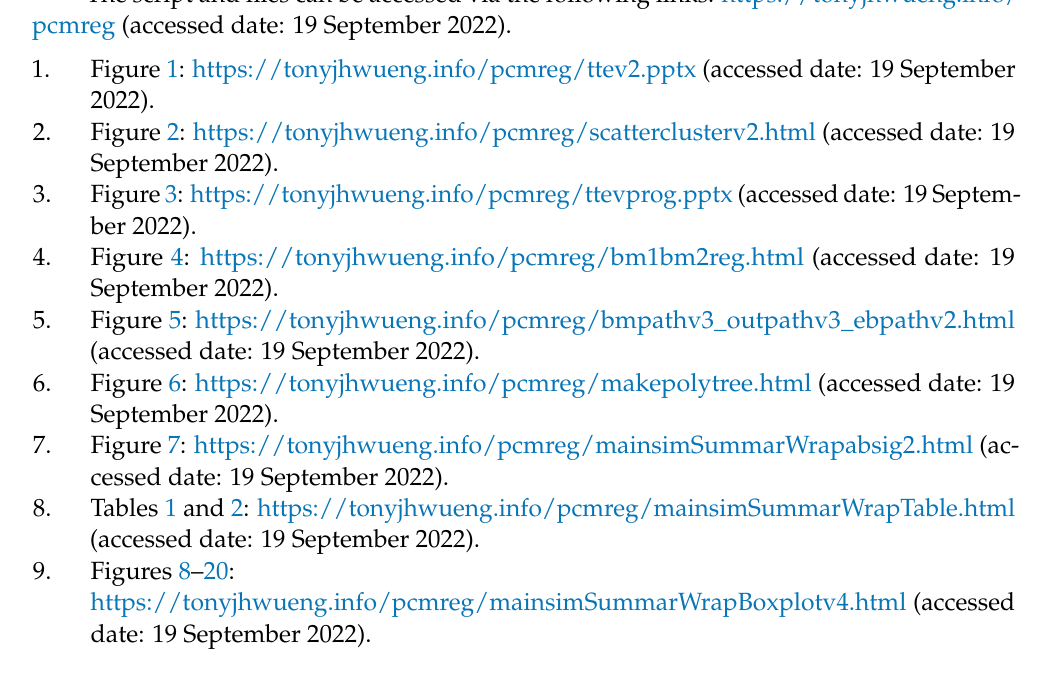
Figure 5: https://tonyjhwueng.info/pcmreg/bmpathv3_outpathv3_ebpathv2.html Figure 6: https://tonyjhwueng.info/pcmreg/makepolytree.html (accessed date: 19 Figure 7: https://tonyjhwueng.info/pcmreg/mainsimSummarWrapabsig2.html (ac-